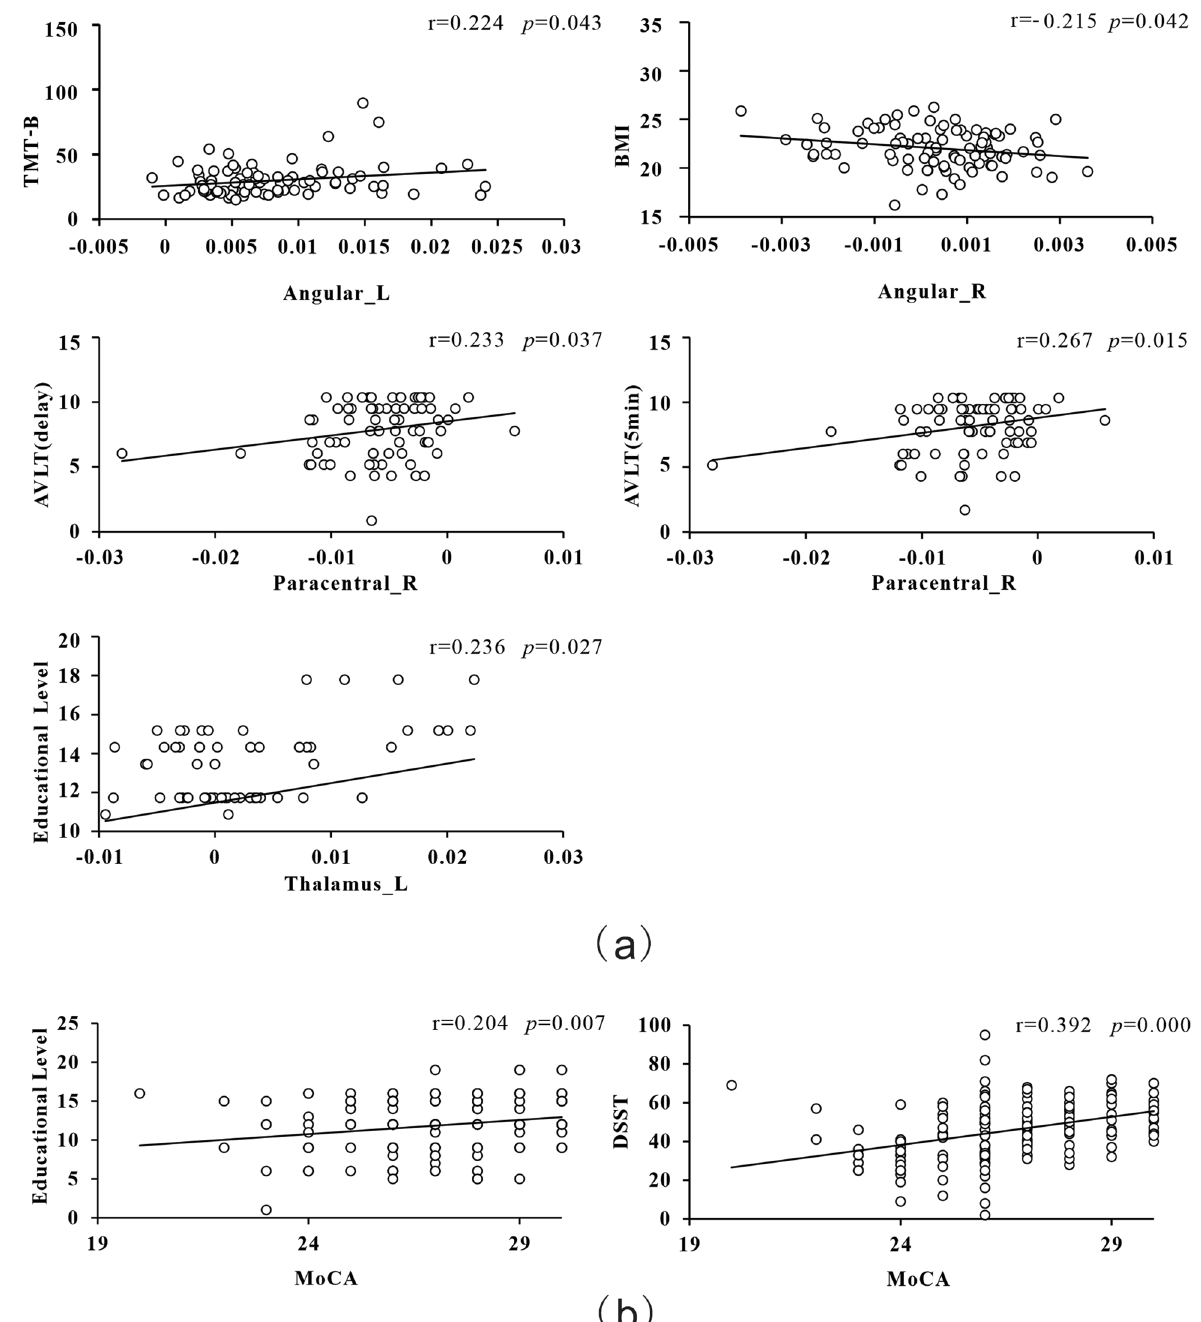
Figure 2. Associations between neuropsychological test scores and functional connectivity. Partial correlation was used to determine the relationship between neuropsychological test scores and functional connectivity. ( a ) Correlation of functional connectivity with neuropsychological test scores ( b ) Correlation between neuropsychological test scores. TMT trail-making test, BMI body mass index, AVLT World Health Organization University of California-Los Angeles auditory verbal learning test, MoCA-B montreal cognitive assessment-B, DSST digit symbol substitution test, L left, R